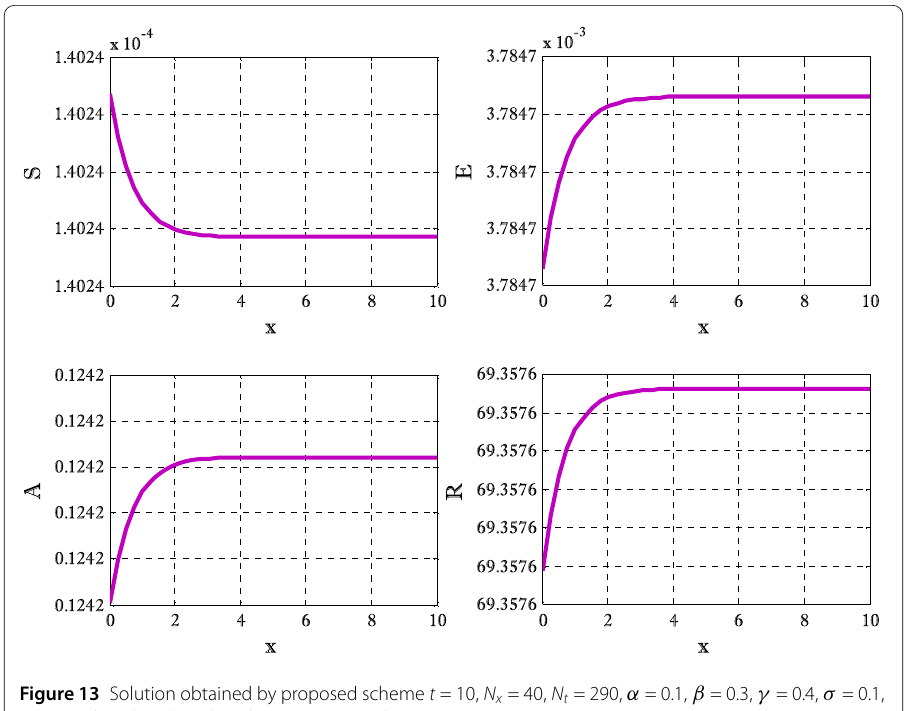
Figure 13 Solution obtained by proposed scheme t = 10, N x = 40, N t = 290, α = 0.1, β = 0.3, γ = 0.4, σ = 0.1, μ = 0.4, d